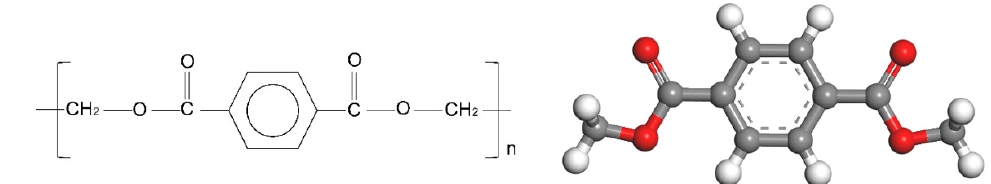
Figure 3. Schematic diagram of the tin free steel (TFS) surface coating structure. Figure 4. Polyethylene terephthalate (PET) molecular formula and model diagram (white is H atom, red is O atom, gray is C atom).